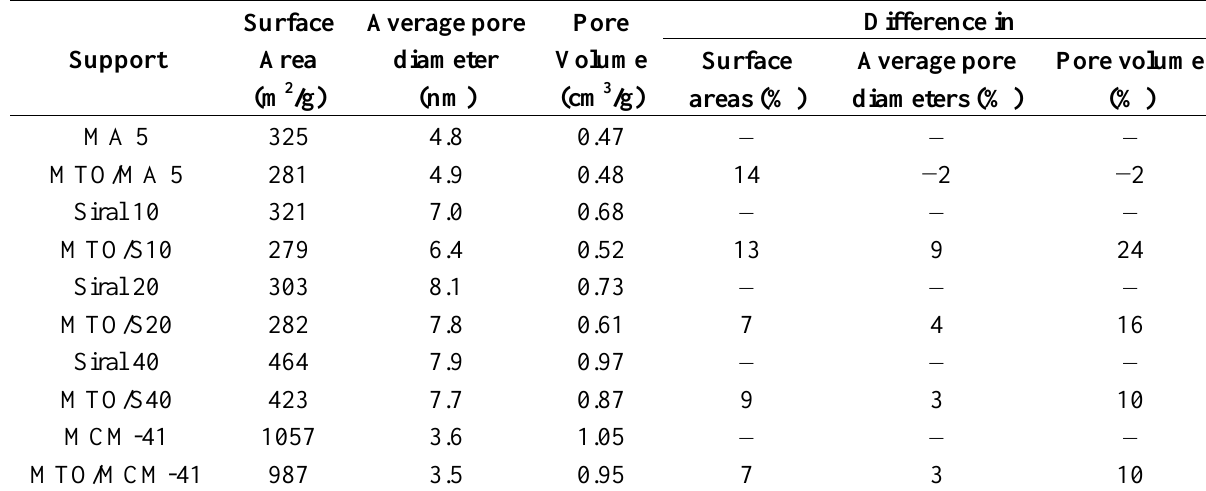
Table 3. Main textural characteristics of supports and of their MTO modified forms (immobilized amount of MTO was 15 mg on 100 mg of supports).